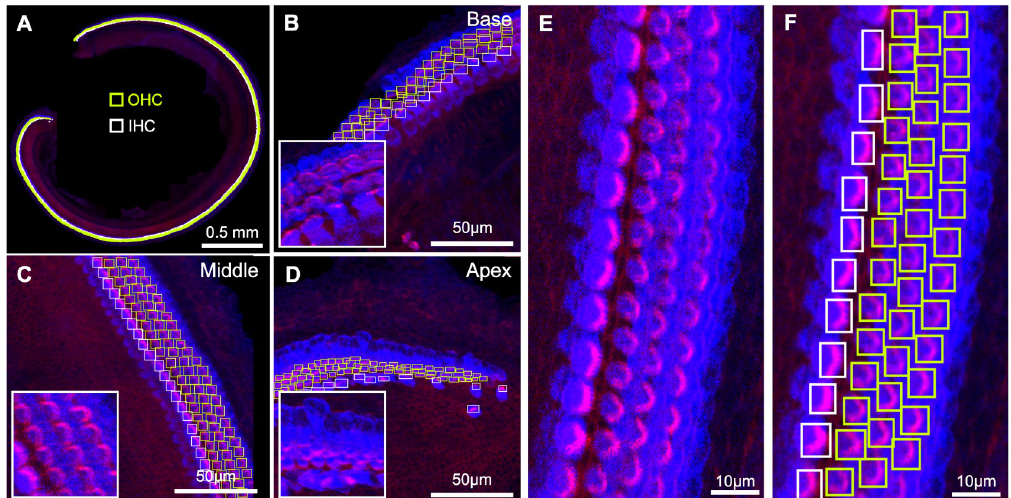
Fig 2. HCAT detection algorithm training data. Early postnatal, wild-type murine hair cells in whole cochlea stained against MYO7A (blue) and phalloidin (magenta) were manually annotated by placing either yellow (OHC) or white (IHC) boxes around each stereocilia bundle ( A–D ) and used as training data for the Faster R-CNN deep learning algorithm. All annotated boxes appear as a thin, pale green strip when rendered in ( A ). Hair cells vary in appearance based on tonotopy, with representative regions of the base ( B ), middle ( C ), and apex ( D ) shown here. Since the boundaries between hair cell cytosol (blue) overlap in maximum intensity projection images ( E ), the bounding boxes for each cell were annotated around the stereocilia bundle and cuticular plate of each hair cell ( F ). HCAT, hair cell analysis toolbox; IHC, inner hair cell; OHC, outer hair cell.